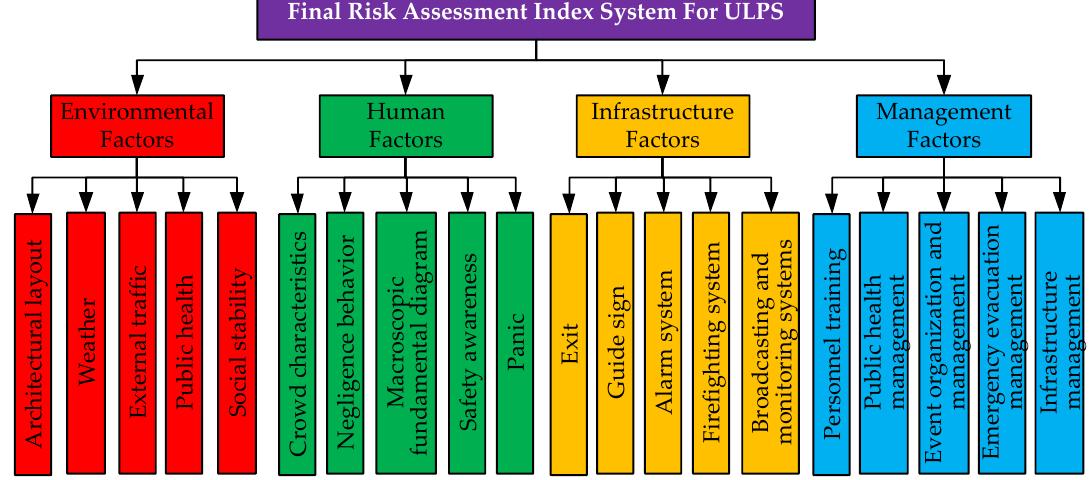
Figure 3. Result of the final risk assessment index system for Urban Large-scale Public Spaces ( ULPS).